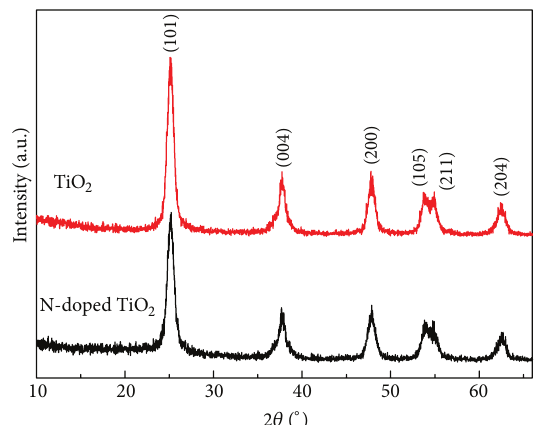
Figure1:XRDpatternsoftheundopedandN-dopedTiO 2 powders.